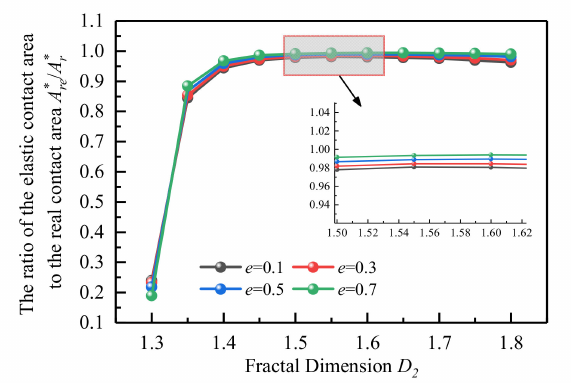
Figure 10. Relationship between the ratio of the elastic contact area to the real contact area and fractal dimension D at different eccentricity e